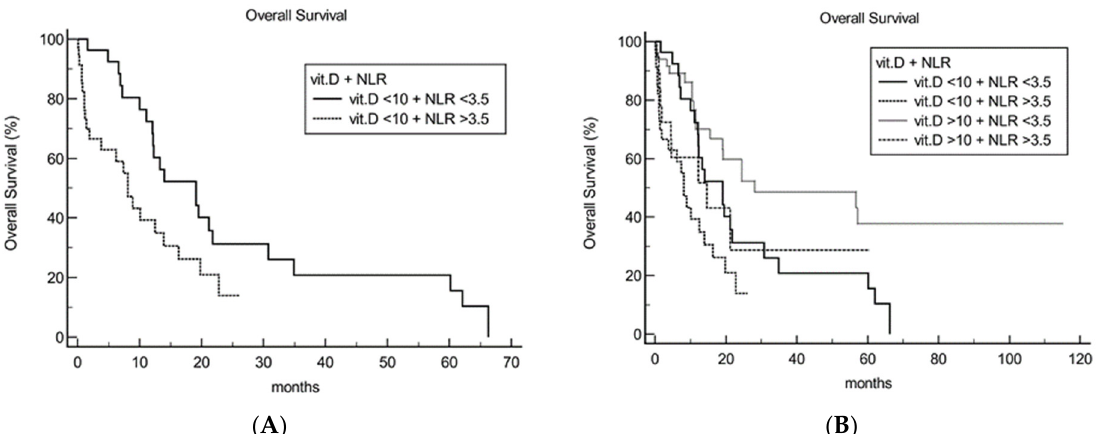
Figure 5. Survival of vitamin D low (25(OH)D <10 ng/mL) ( A ) and high (25(OH)D >10 ng/mL) ( B ) patients could be further stratified by NLR level (< vs. > 3.5). NLR: Neutrophil-to-lymphocyte ratio; vit.D: Vitamin D.